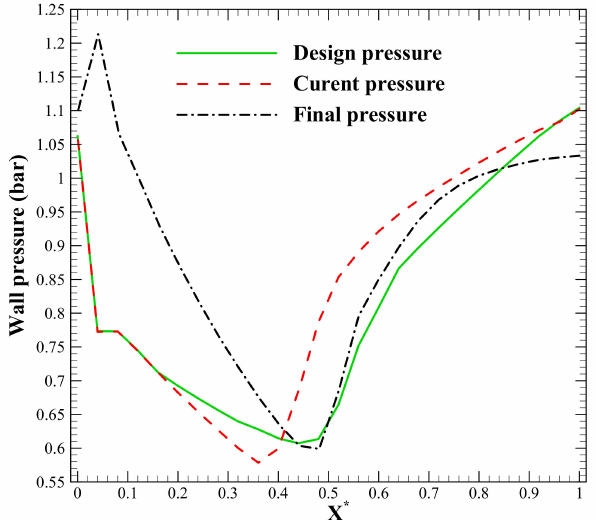
Figure 14. Initial (current), target (design), and final pressure distributions versus non- dimensionalized X*—coordinate, for the first design of a transonic blade by UESA with the spine constraint